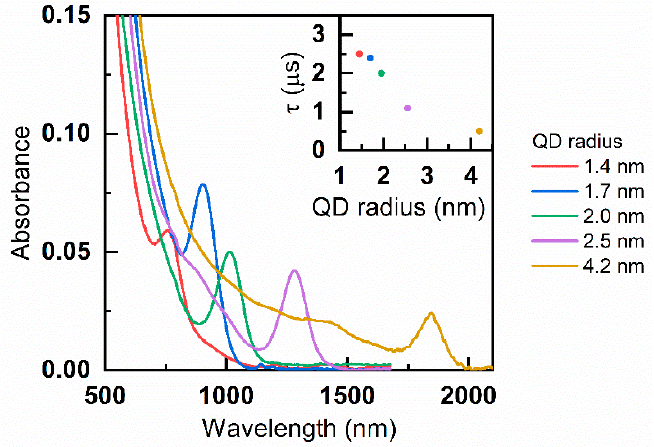
Figure 1. Quantum dot (QD) solution absorbance spectra; inset—QD carrier relaxation time, obtained from time-resolved photoluminescence measurement.